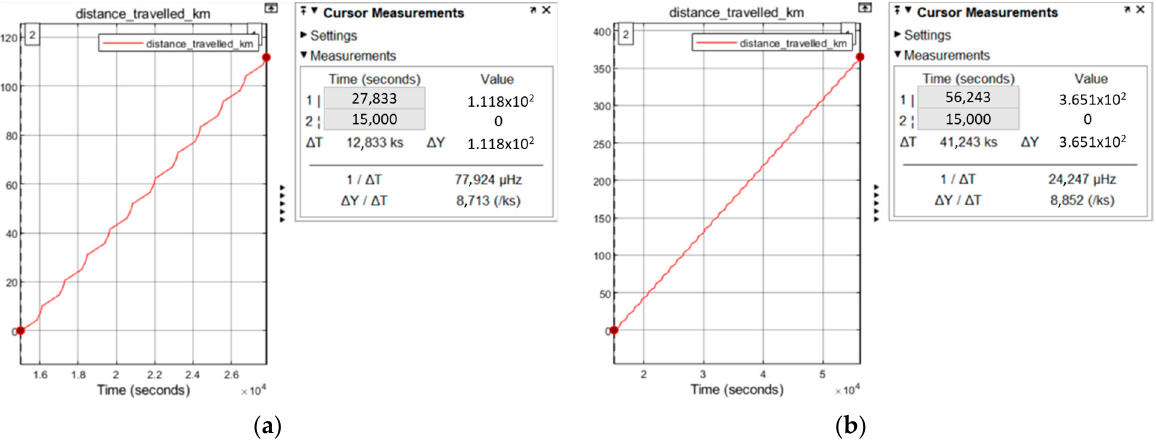
Figure 15. Comparison of ( a ) EV mode and ( b ) REX mode ranges for NEDC driving cycle.